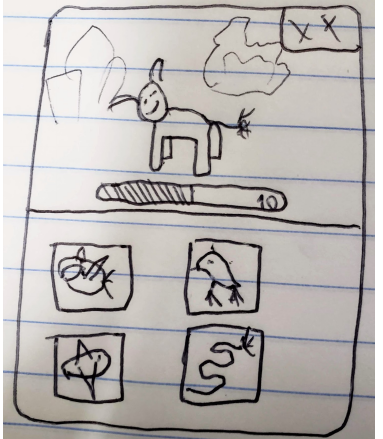
Figure 5. Design of the initial screen of the proposed solution. At the top, there is the daily progress (represented by a bar) and an animal, whose emo- tion is reflected by the daily progress. At the bottom, there is a menu to access each game, represented by a different animal.